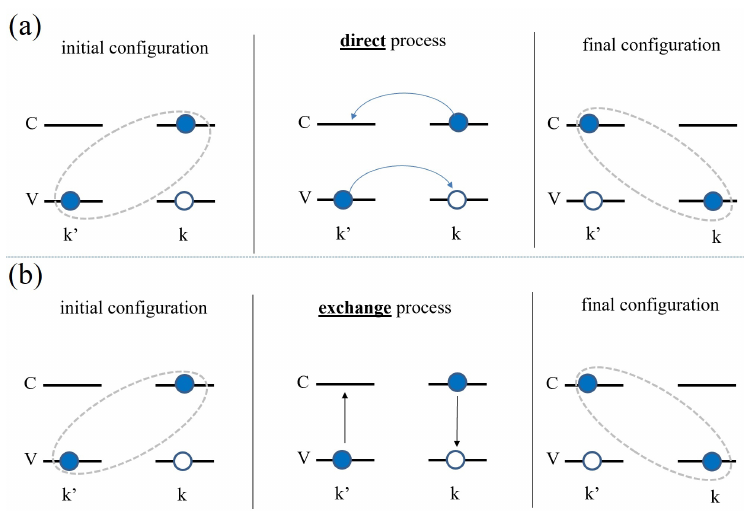
Figure 9. Graphical representation of two types of interaction between an electron and a hole: ( a ) direct process ( b ) exchange